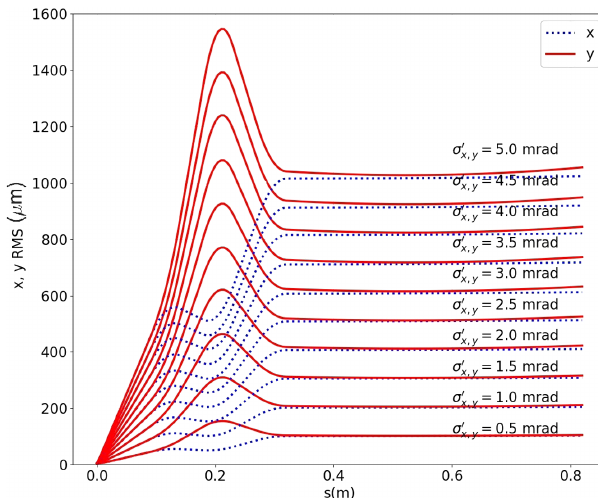
FIG. 10. Transverse beam sizes for various beam divergences over distance with a triplet.